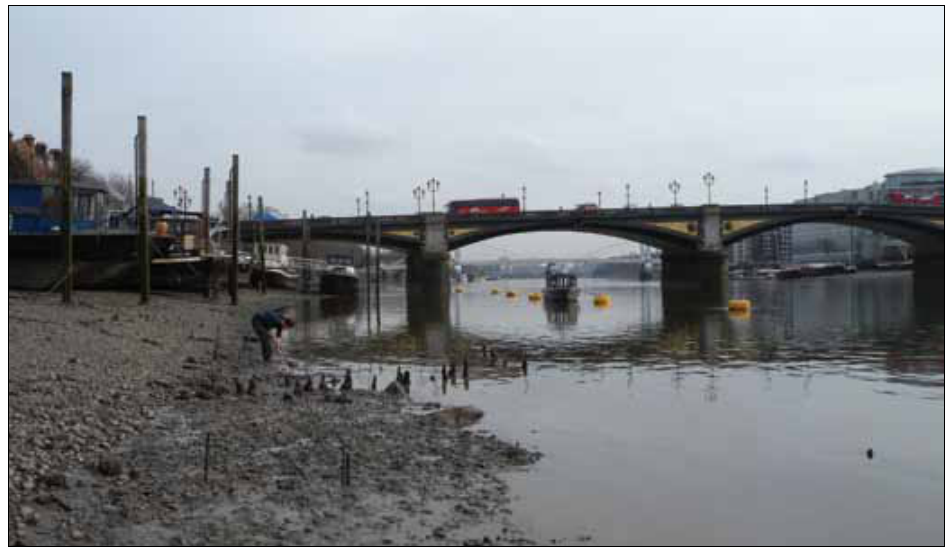
Fig. 6: Sampling on the foreshore at Chelsea (photo N.